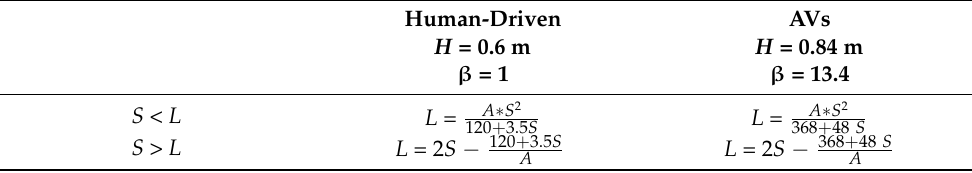
Table 5. Formulas for calculating the sag curve length for human-driven vehicles and AVs.